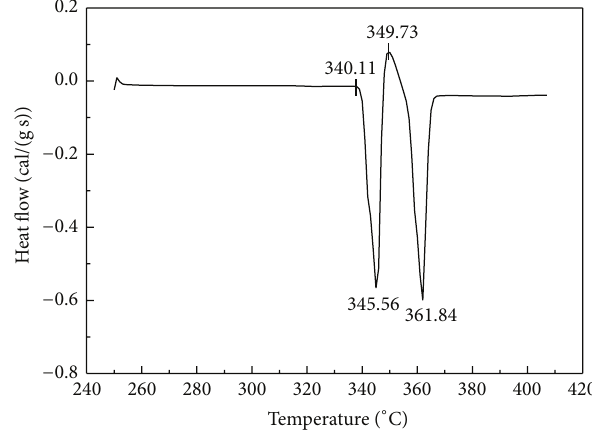
Figure 2: DSC thermogram (heating curve) of as-cast Mg-35Zn- 3Ca